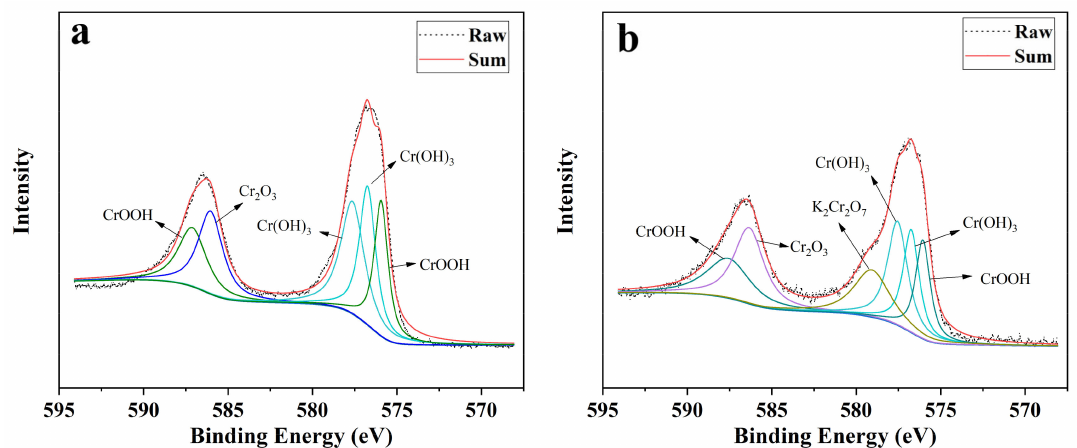
Figure 3. Cr 2p XPS spectra of reacted nZVI ( a ) and B-nZVI ( b